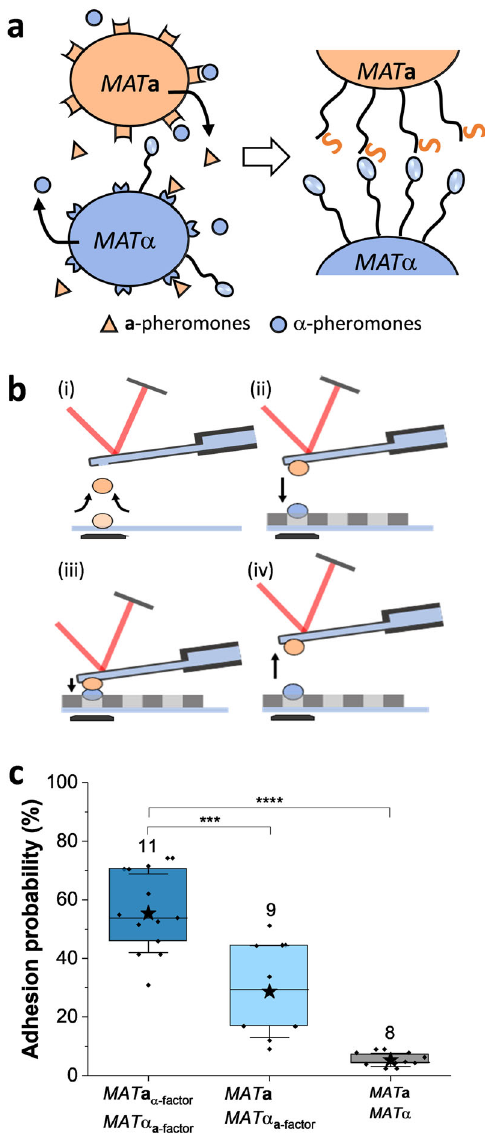
Fig. 1 FluidFM as a single-cell manipulation tool to study sexual agglutination. a Scheme of the mating processes between Saccharomyces cerevisiae MAT a and MAT α cells. Mating occurs through the speci fi c interaction of a - and α -agglutinins whose surface expression is enhanced when MAT a are exposed to α -pheromones and MAT α are exposed to a pheromones. b Scheme of the fl uidFM set-up showing the main steps for single cell – cell measurements. (i) A single MAT a cell is fi rst immobilized at the aperture of the fl uidFM cantilever by applying a negative pressure. (ii) The single-cell probe is then brought into contact with a single MAT α cell trapped in a porous membrane, (iii) being either or not maintained in contact for 30 min, and (iv) fi nally retracted to quantify cell – cell adhesion forces. c Box plots of the adhesion probability between MAT a and MAT α cells showing the key role of pheromones treatment: (i) both mating types were treated with the opposite mating pheromones ( MAT a α -factor and MAT α MAT α cells were treated with MAT a pheromones a -factor ), (ii) only ( MAT a and MAT α a -factor ) and (iii) none of the cells were pretreated with pheromones ( MAT a and MAT α ). Stars are the mean values, lines the medians, boxes the 25 – 75% quartiles, and whiskers the SD from N independent cell pairs ( N is indicated above the corresponding